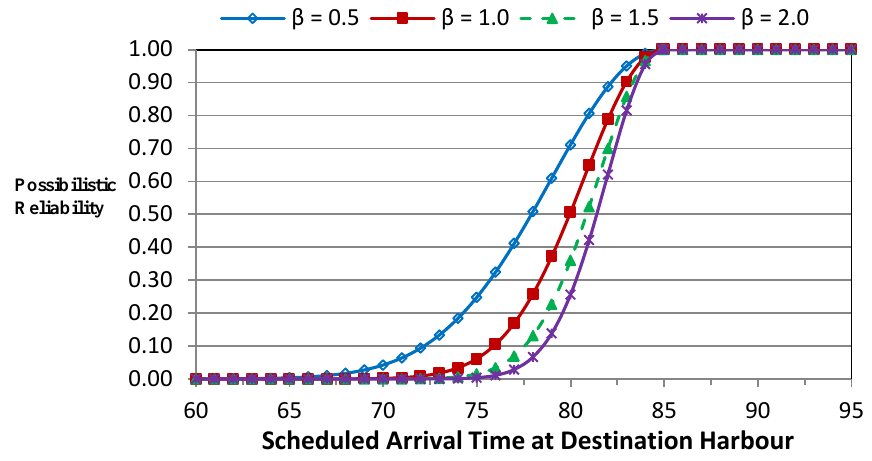
Figure 7. Sensitivity of parameter β in third case.